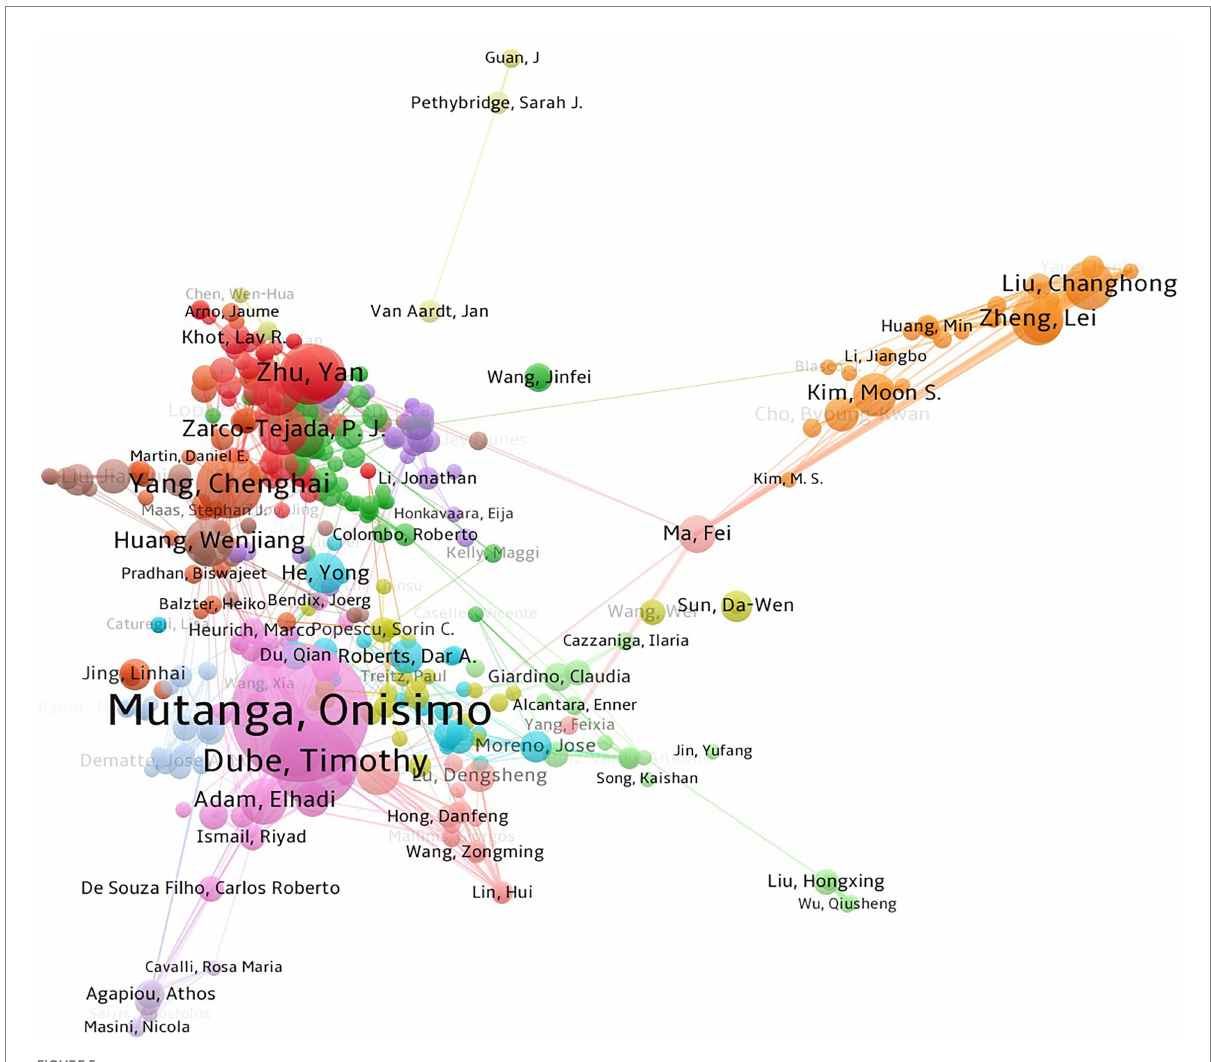
FIGURE 5 Co-occurrence map of agricultural multispectral researcher collaboration in 2002–2021.